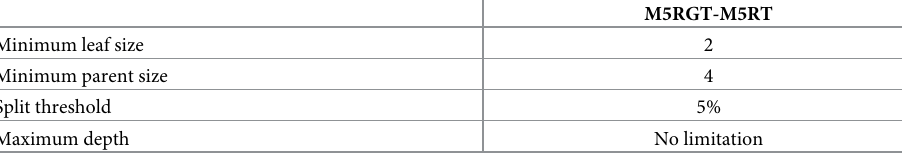
Table 4. Model parameters for M5RGT and M5RT.